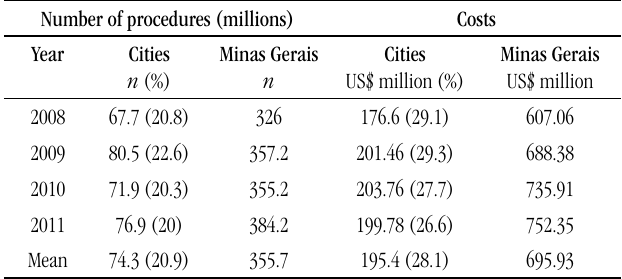
tABLE 2 – Annual amount spent on SUS patients procedures in the studied cities in comparison with the state of Minas Gerais, 2008-2011 (US$ million) Number of procedures